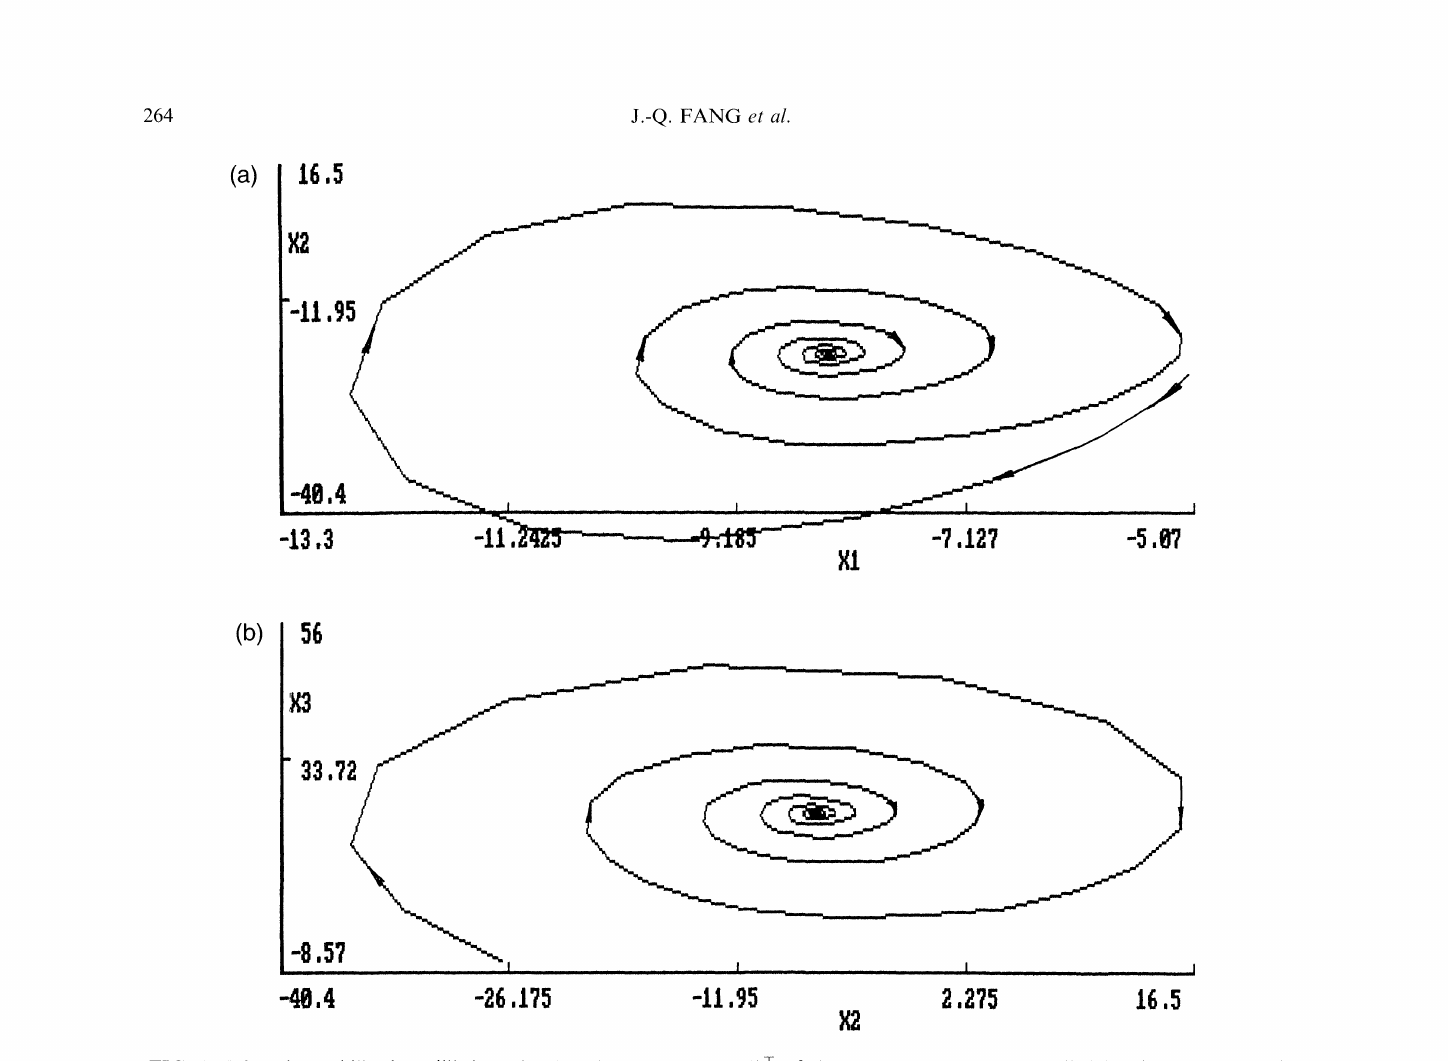
FIGURE 3 The stabilized equilibrium Q=(-8.485,-8.485,27.000) n- of the Lorenz attractor, controlled by the same control law as in Fig. 2, but using a different initial condition x(0)=(-15,-15,25) x3-x2